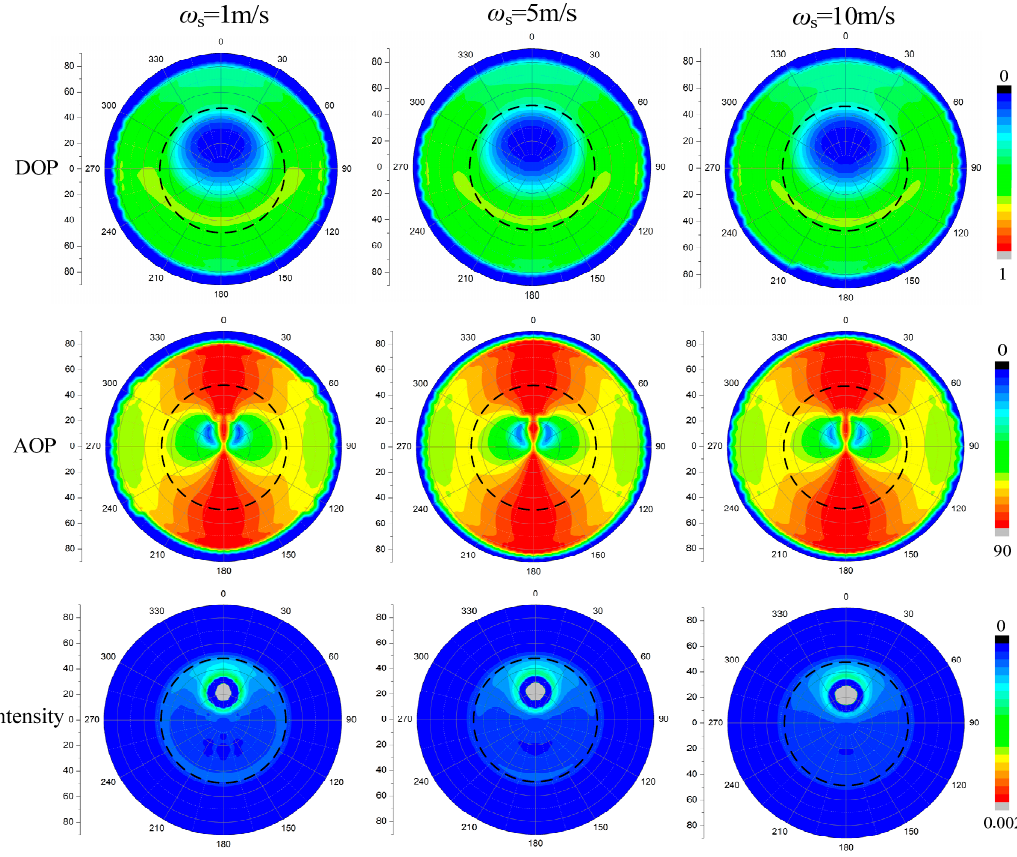
Figure 10. The DOP, AOP and intensity patterns of transmitted light under a wavy water surface ◦ , wind direction is 0 ◦ with different wind speeds, where the SZA is 30°, wind direction is 0° . different wind speeds, where the SZA is 30